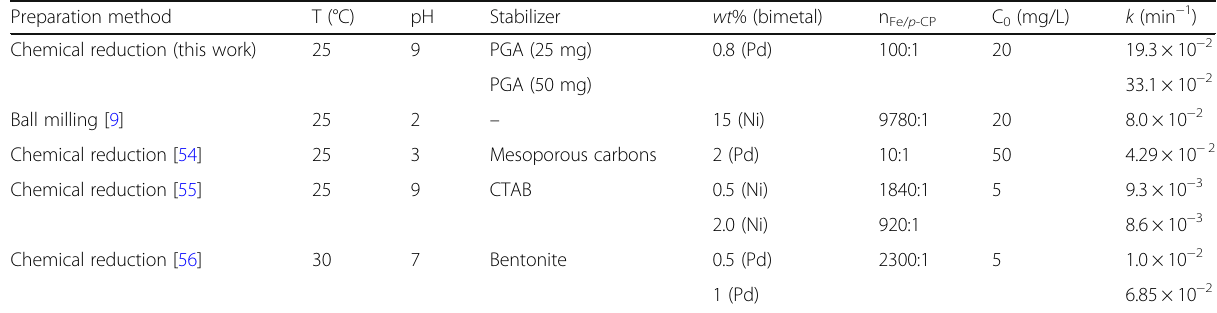
Table 1 Comparison of the rate constant ( k ) of dechlorination of p -CP in different dechlorination systems Preparation